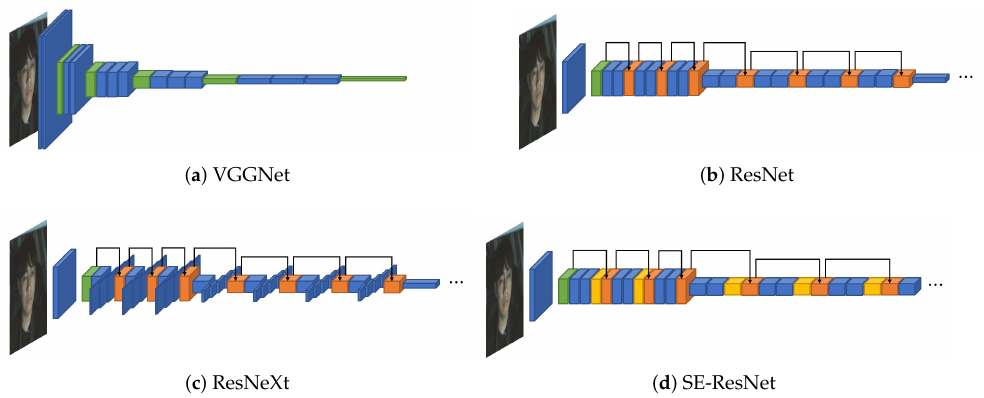
Figure 2. ( a ) VGGNet with vanilla CNN (blue) and max-pooling (green). ( b ) ResNet with vanilla CNN (blue), max-pooling (green), and shortcut connection (orange). ( c ) ResNeXt with vanilla CNN (blue), max-pooling (green) and shortcut connection (orange). ( d ) SE-ResNet with vanilla CNN (blue), max-pooling (green), shortcut connection (orange) and SE block (yellow).